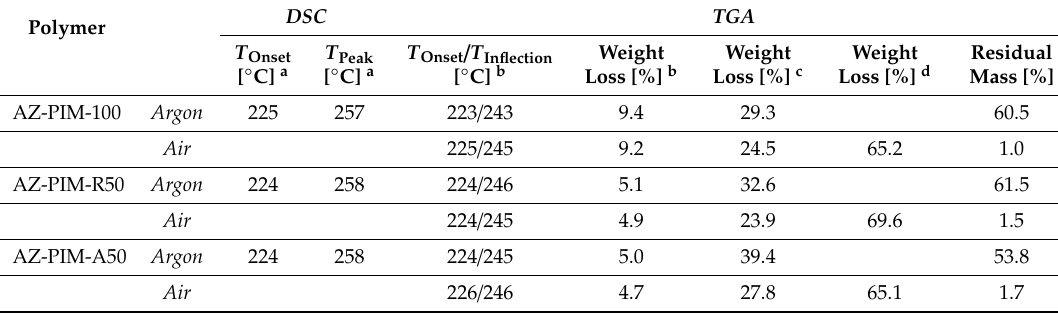
Table 1. Results of thermal characterization of AZ-PIMs.